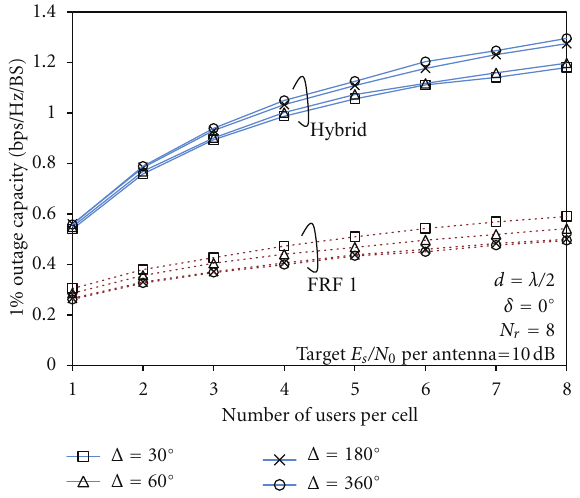
Figure 8: Cellular outage capacity with 1% outage probability.